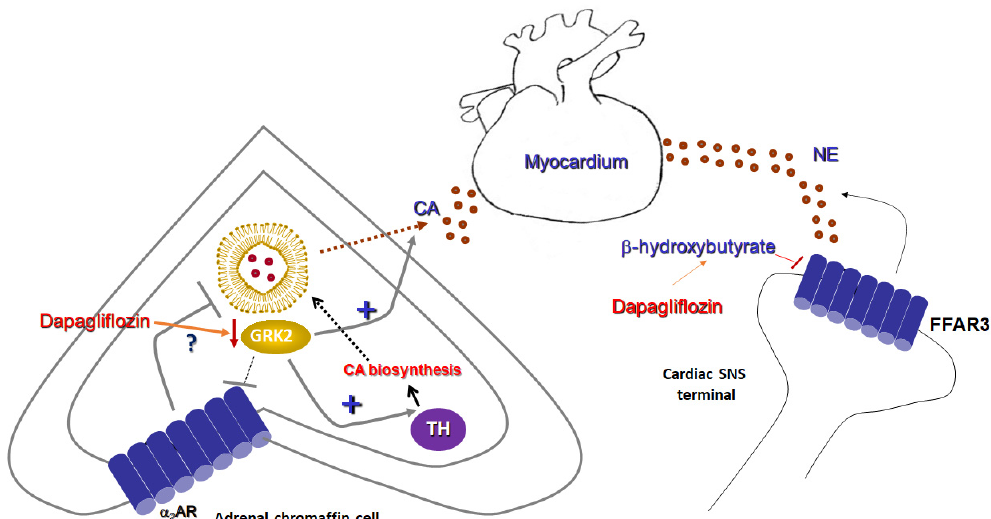
Figure 2. Sympatholytic effects of a SGLT2 inhibitor (dapagliflozin). ( Left ): Proposed sympatholytic mechanism in the chromaffin cell of the adrenal medulla. ( Right ): Potential sympatholytic mechanism in cardiac sympathetic nerve terminals. α 2 AR: Alpha2-adrenergic receptor; CA: Catecholamine; FFAR3: Free fatty acid receptor-3 (GPR41); GRK2: G protein-coupled receptor kinase-2; NE: Norepinephrine; SNS: Sympathetic nervous system; and TH: Tyrosine hydroxylase.